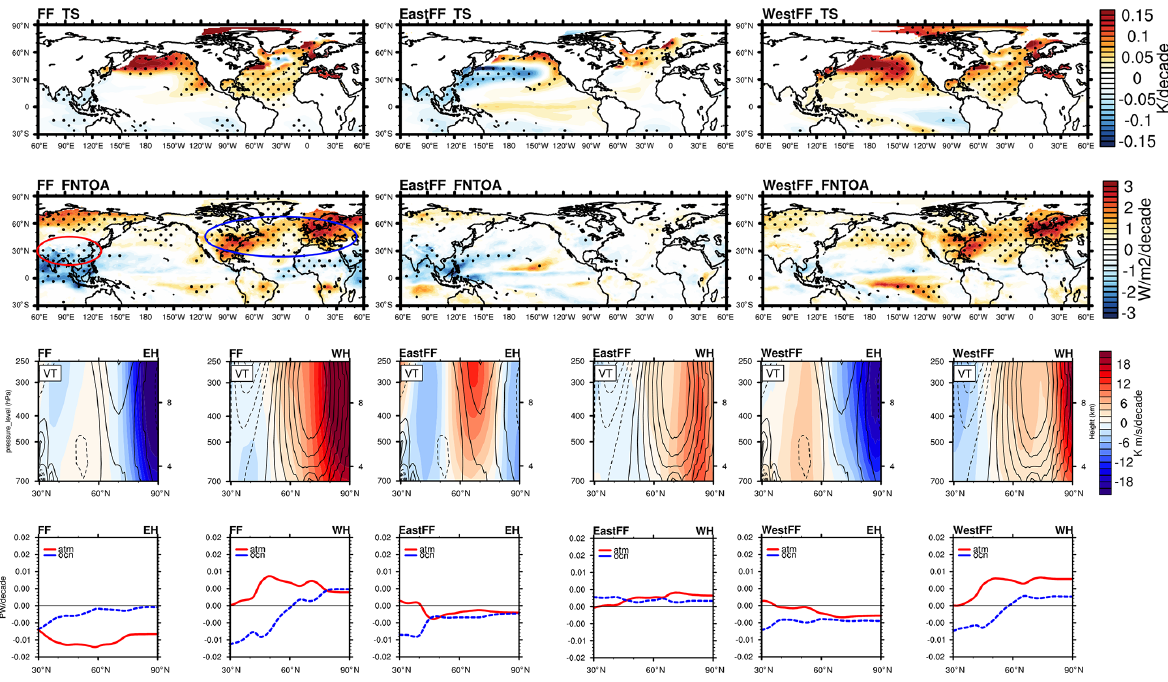
Figure 10. The first and second rows show the 40-year sea surface air temperature trend (SAT) and net energy flux at TOA ( R toa ). Arctic regions with significant sea ice changes are masked. The blue (red) circles in the second row indicate the major regions with a decline (increase) in aerosol emission. The third row shows 40-year trends of zonal mean meridional heat transport (ZMMHT) in EH and WH. The positive values (solid lines for climatology and red shading for the long-term trend) indicate the poleward transfer. The arrows indicate the energy transfer responses relative to the climatology. The fourth row is similar to Fig. 7 but shows the regional northward energy transport (Pwatt per decade; northward positive) in EH and WH. The dashed blue lines indicate oceanic northward energy transport (OET), while the solid red lines indicate atmospheric northward energy transport